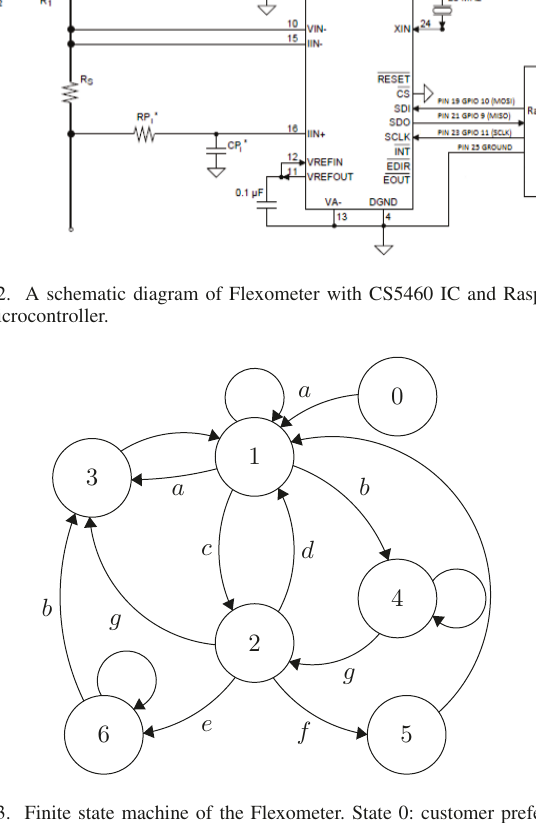
Fig. 3. Finite state machine of the Flexometer. State 0: customer preference initialization, 1: acquiring data and waiting for control signal, 2: decoding and encoding the received signal, 3: Clearing or overwriting the instant in logger, 4: generating desire control preference (e.g. bid), 5: sending, 6: performs desire action and waits till completion. Transition a: customer preference (i.e. nvParam), b: status, c: received control signal , d: wrong signal, e: decoded signal, f: encoded signal, g: generated control preference (e.g. bid).